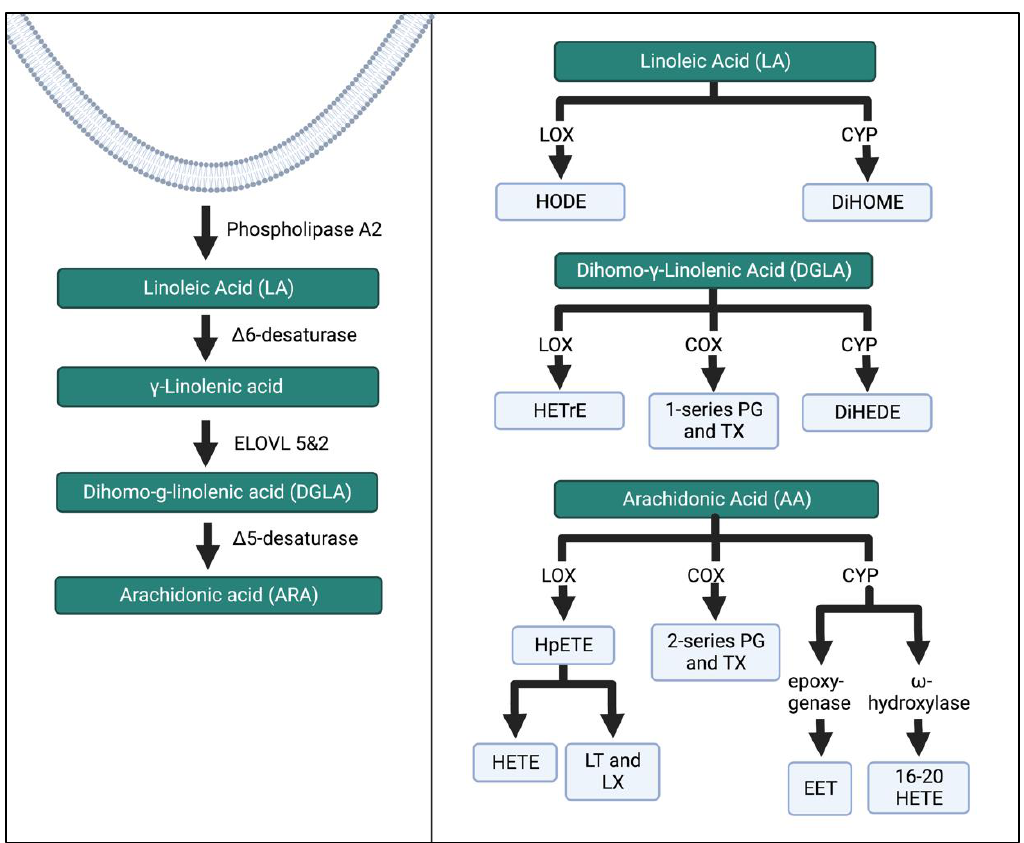
Figure 4. N-6 FA metabolism through the LOX, COX, and CYP enzymatic pathways. These pathways have been simplified from previous research [27,34]. ELOVL, elongation of very long chain fatty acid elongase protein; HODE, hydroxy-octadecadienoic acids; DiHOME, dihydroxy-octadecenoic acids; HETrE, hydroxy-eicosatrienoic acids; DiHEDE, dihydroxy-eicosadienoic acid; PG, prostaglandin; TX, thromboxane; HpETE, hydroperoxy-eicosatetraenoic acid; HETE, creates hydroxyeicosatetraenoic acids; LT, leukotriene; LX, lipoxin; EET, epoxyeicosatrienoic acid. The Figure was created in Biorender. ALA, EPA, and DHA are major substrates for intermediates and bioactive compounds (Figures 5 and 6). ALA produces hydroxy-octadecatrienoic acid (HOTrE) via LOX enzymes activate autophagy, and induce apoptosis [35]. CYP activity creates dihydroxy-octadecadienoic acid (DiHODE) whose role and tissue distribution are not completely understood